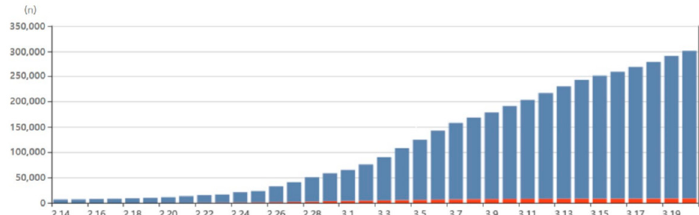
Figure 3. Cumulative numbers of positive and negative test results for severe acute respiratory syndrome coronavirus 2 (SARS-CoV-2). In total, 301,139 people underwent testing for SARS-CoV-2, and 8,652 (2.9%) tested positive. (red: cases confirmed as SARS-CoV-2 positive; blue: cases confirmed as SARS-CoV-2 negative) Source: www.coronaboard.kr .